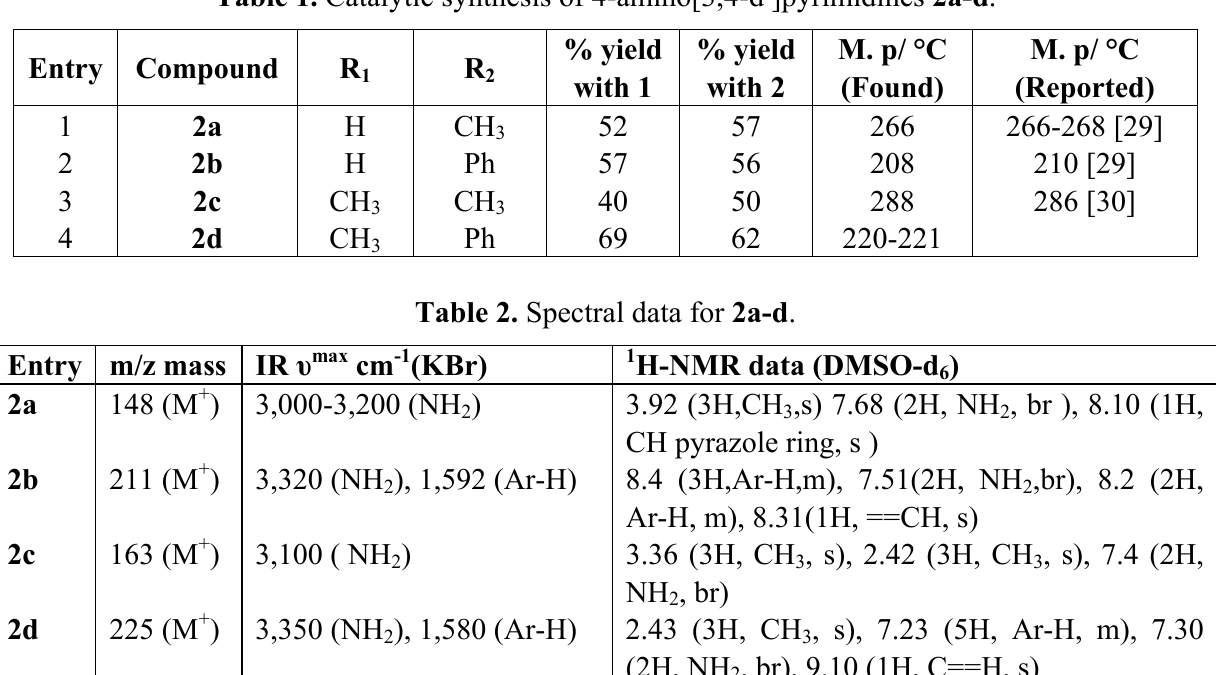
Table 1. Catalytic synthesis of 4-amino[3,4-d ]pyrimidines 2a-d .